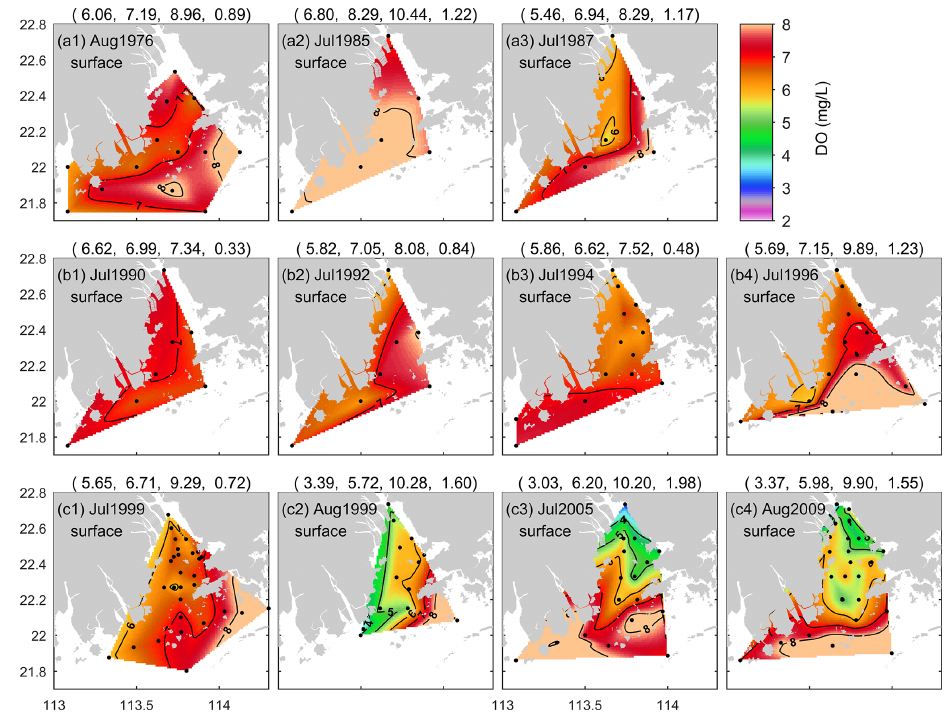
Figure 5. DO distributions at the surface of the PRE in